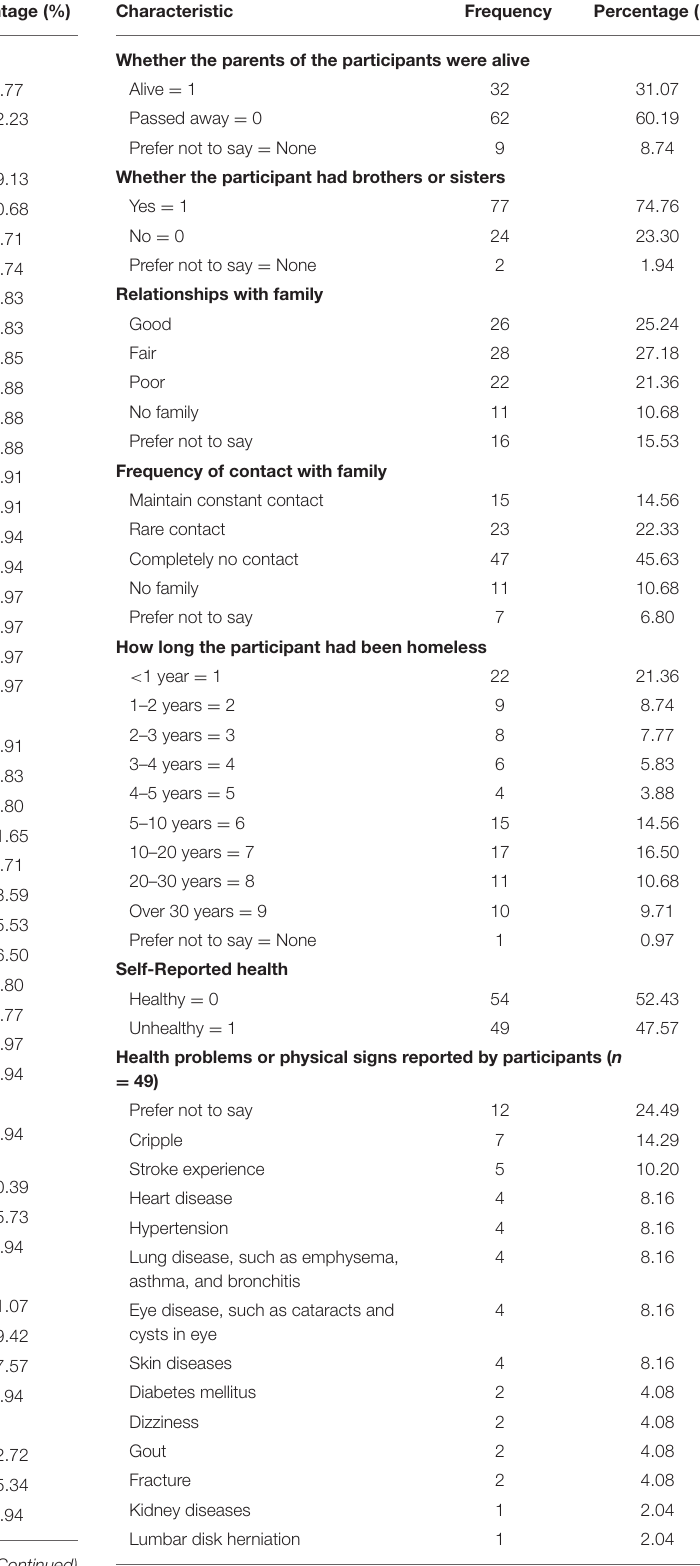
TABLE 1 | Basic characteristics of the respondents ( n =